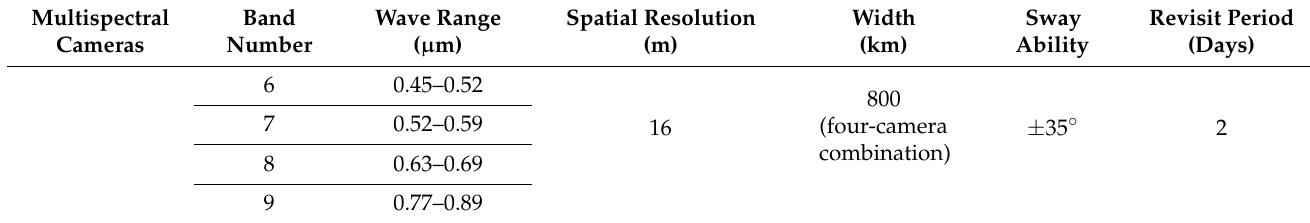
Table 1. GF-1 Satellite WFV camera